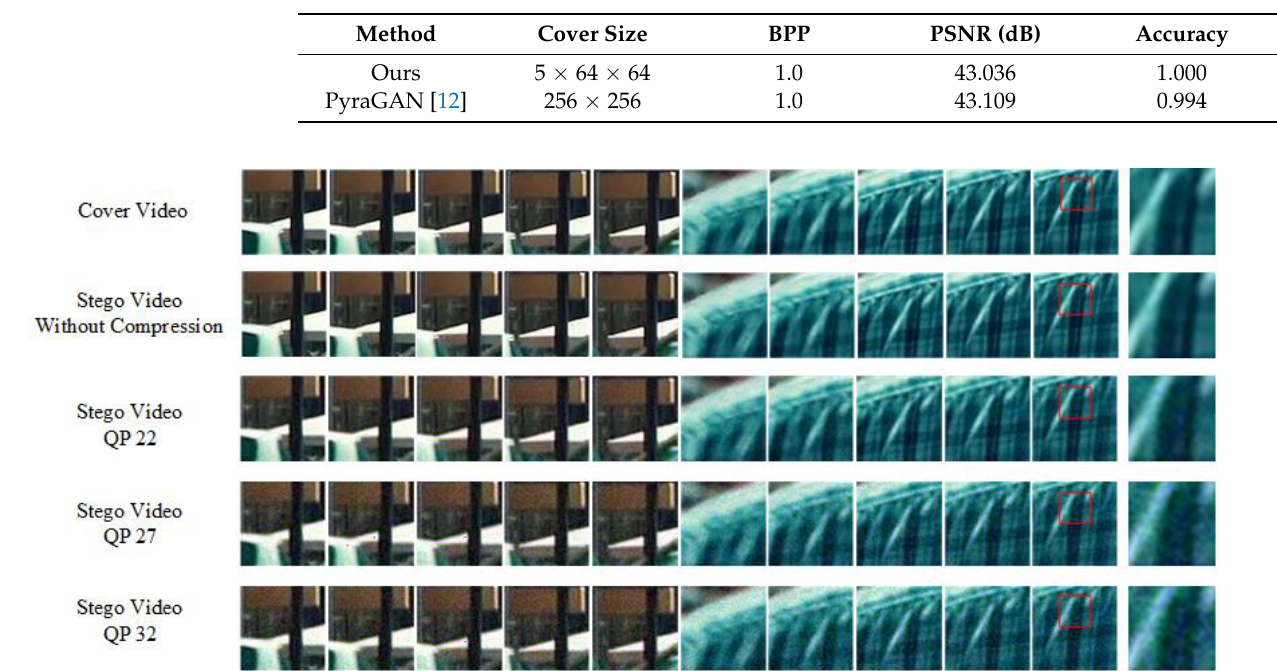
Table 1. Performance of model without noise layer.